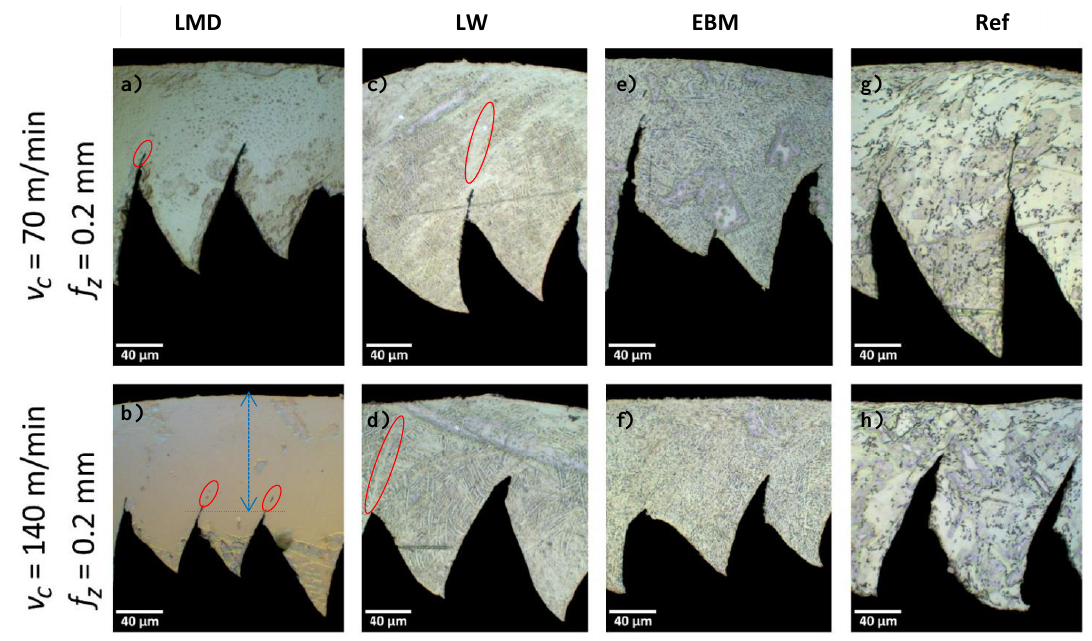
Figure 16. Chip geometry for LMD, LW, EBM, and Ref for two cutting speeds ( v c ) of 70 m / min ( a , c , e , g ) and 140 m / min ( b , d , f , h ). The feed rate ( f z ) was constant at 0.2 mm.